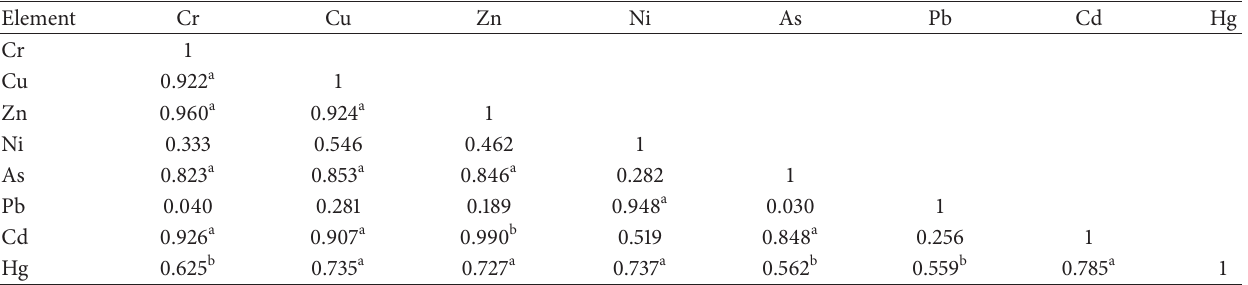
Table 4: Analysis of correlation about heavy metals in surface sediments from TGR